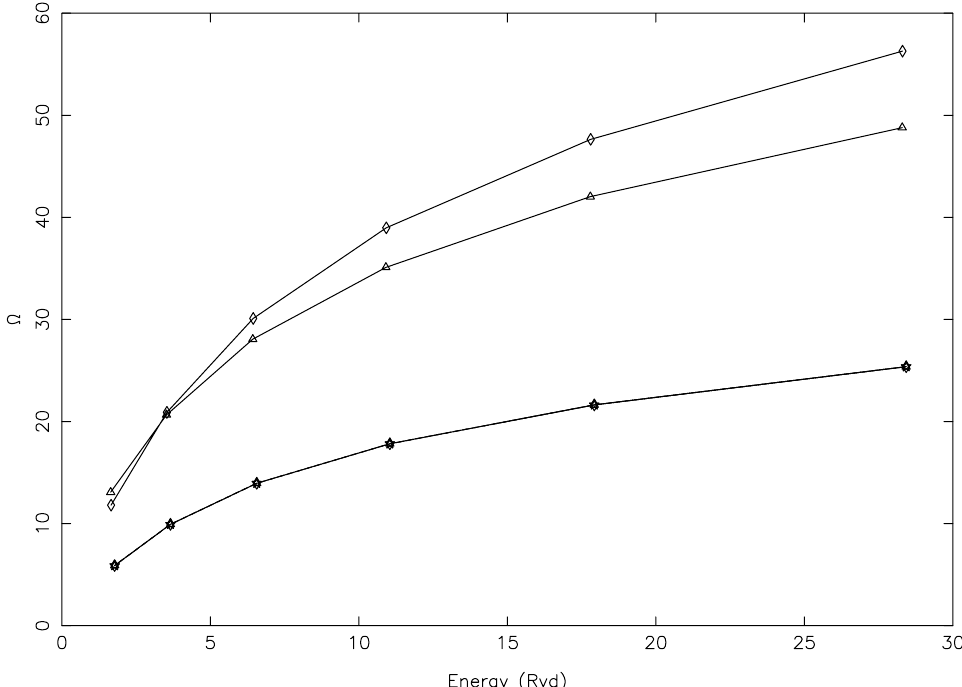
Figure 2. Our calculated values of Ω with FAC for the 4–29 (triangles: 3p 2 1 D 2 –3s3p 3 ( 2 D) 1 D o (diamonds: 3p 2 1 D 2 –3p3d 1 F o